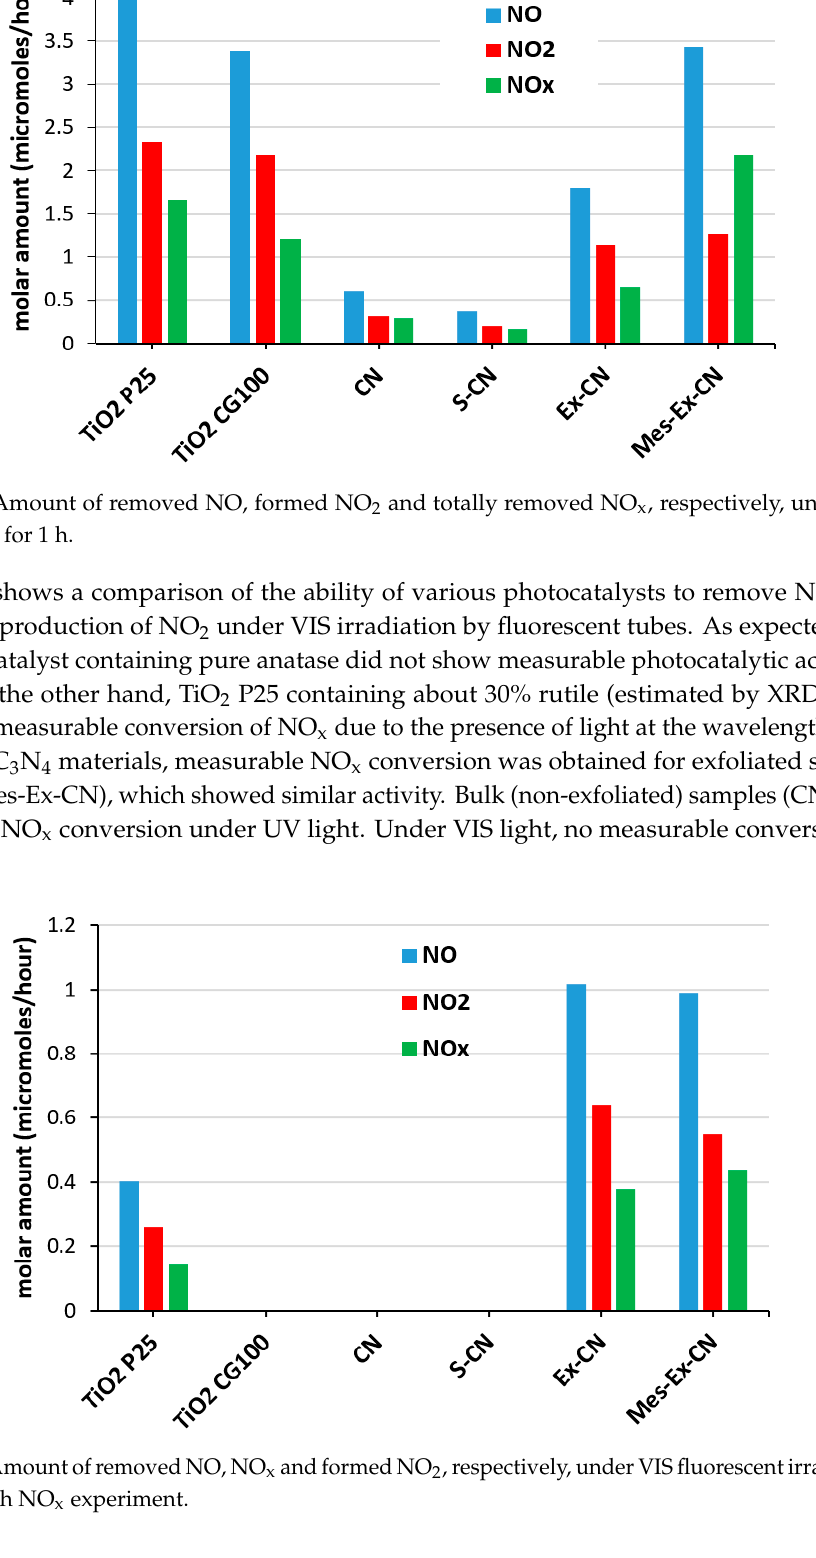
Figure 9. Amount of removed NO, NO x and formed NO 2 under VIS LED irradiation during 1 h of experiment. The performance of the studied nanomaterials upon continuous exposure was also followed by EPR, as the photogenerated charge carriers and their behaviour are coupled with the emergence of paramagnetic species. The UVA ( λ max = 365 nm) as well as visible-light ( λ > 420 nm) exposure of the studied nanomaterials led to an increase in the intensity of the Lorentzian single line at g = 2.0038, while a more prominent effect was induced by visible-light exposure (Figure 10a). The increase in the intensity of the Lorentzian signal monitored upon photoactivation reflects the process of charge carrier formation/trapping. The signal is ascribed to the electrons in the localized states, especially the surface-trapped photogenerated electrons with preferentially carbon character, and the missing hyperfine interaction of nitrogen nuclei is attributed to the EPR line broadening [14,15]. To compare the effect of the light exposure on all the studied nanomaterials, the ratio of EPR integral intensity elucidated from the double-integrated X-band EPR spectra of the samples measured at RT upon UVA